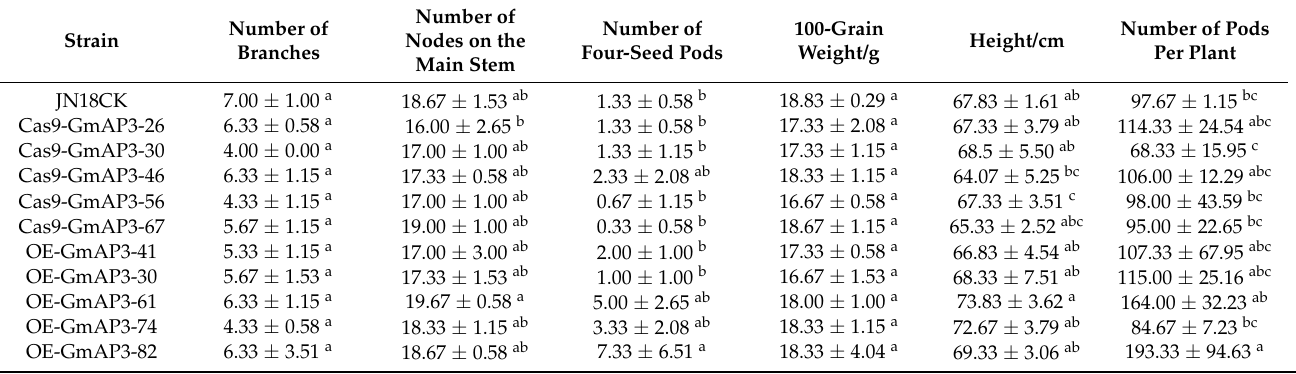
Table 1. Determination of agronomic characters of transgenic soybean. Different lowercase let- ters represent significant differences from each other, and repeated letters represent no significant